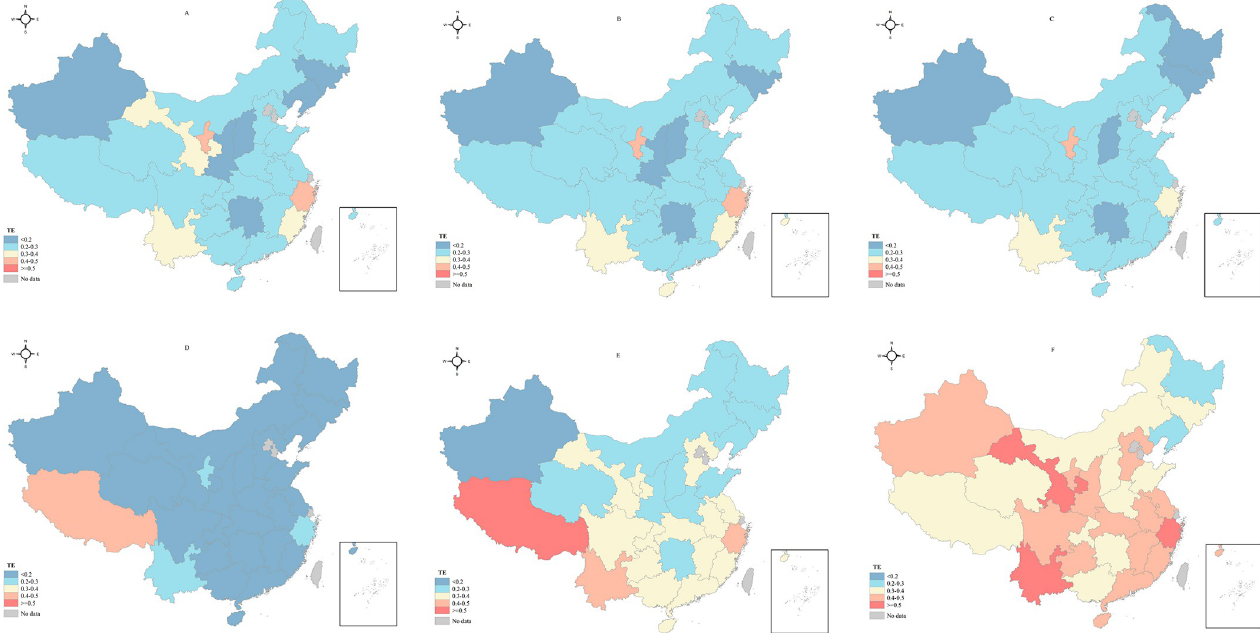
Fig 4. Distribution map of TE in mainland China from 2013 to 2018. A: 2013; B: 2014; C:2015; D:2016; E:2017; F:2018. These figures are drawn based on the standard map from Resource and Environment Science and Data Center